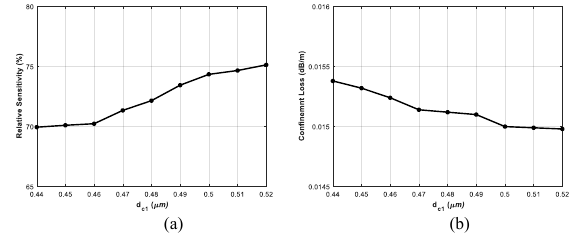
FIGURE 5. Variation of a) the relative sensitivity and b) the confinement loss for different values of d c1 , while other parameters are kept constant.